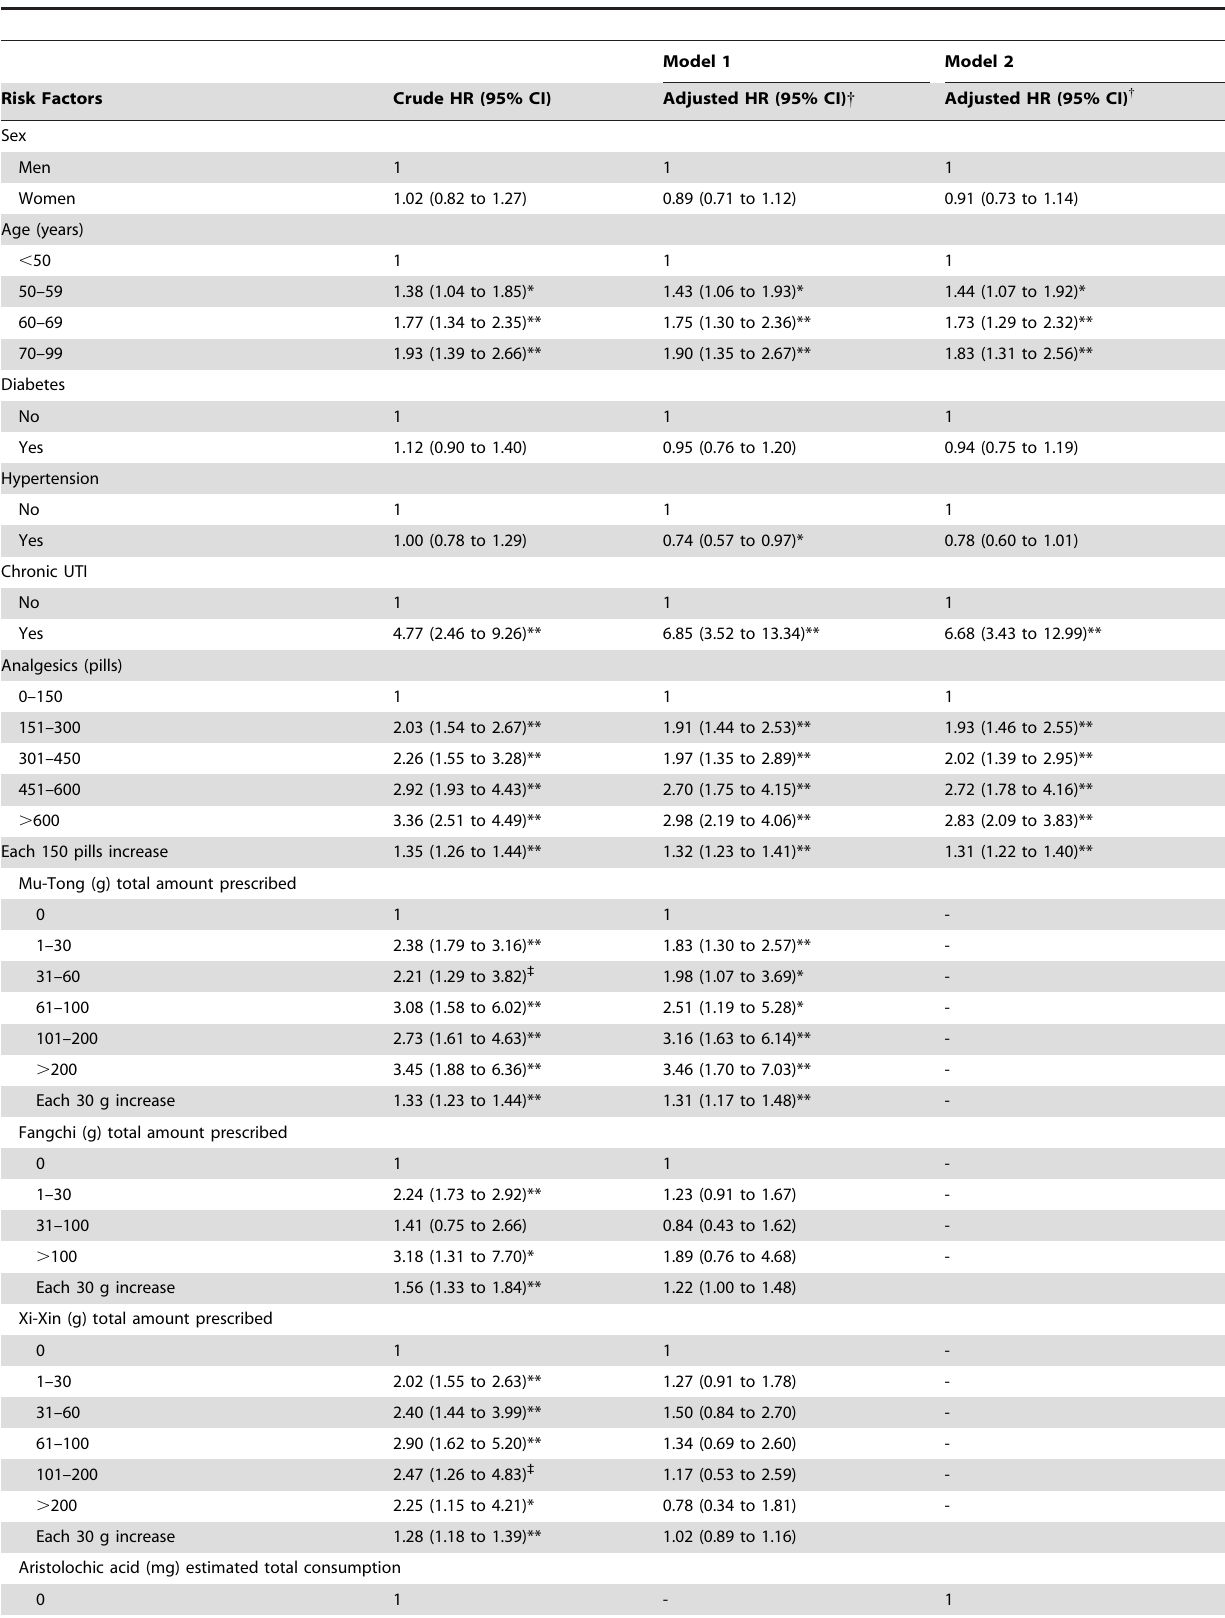
Table 2. Crude and adjusted hazards ratios (HR), and 95% confidence intervals (CI) estimated from multivariate Cox regression models for urinary tract cancer developed in patients with